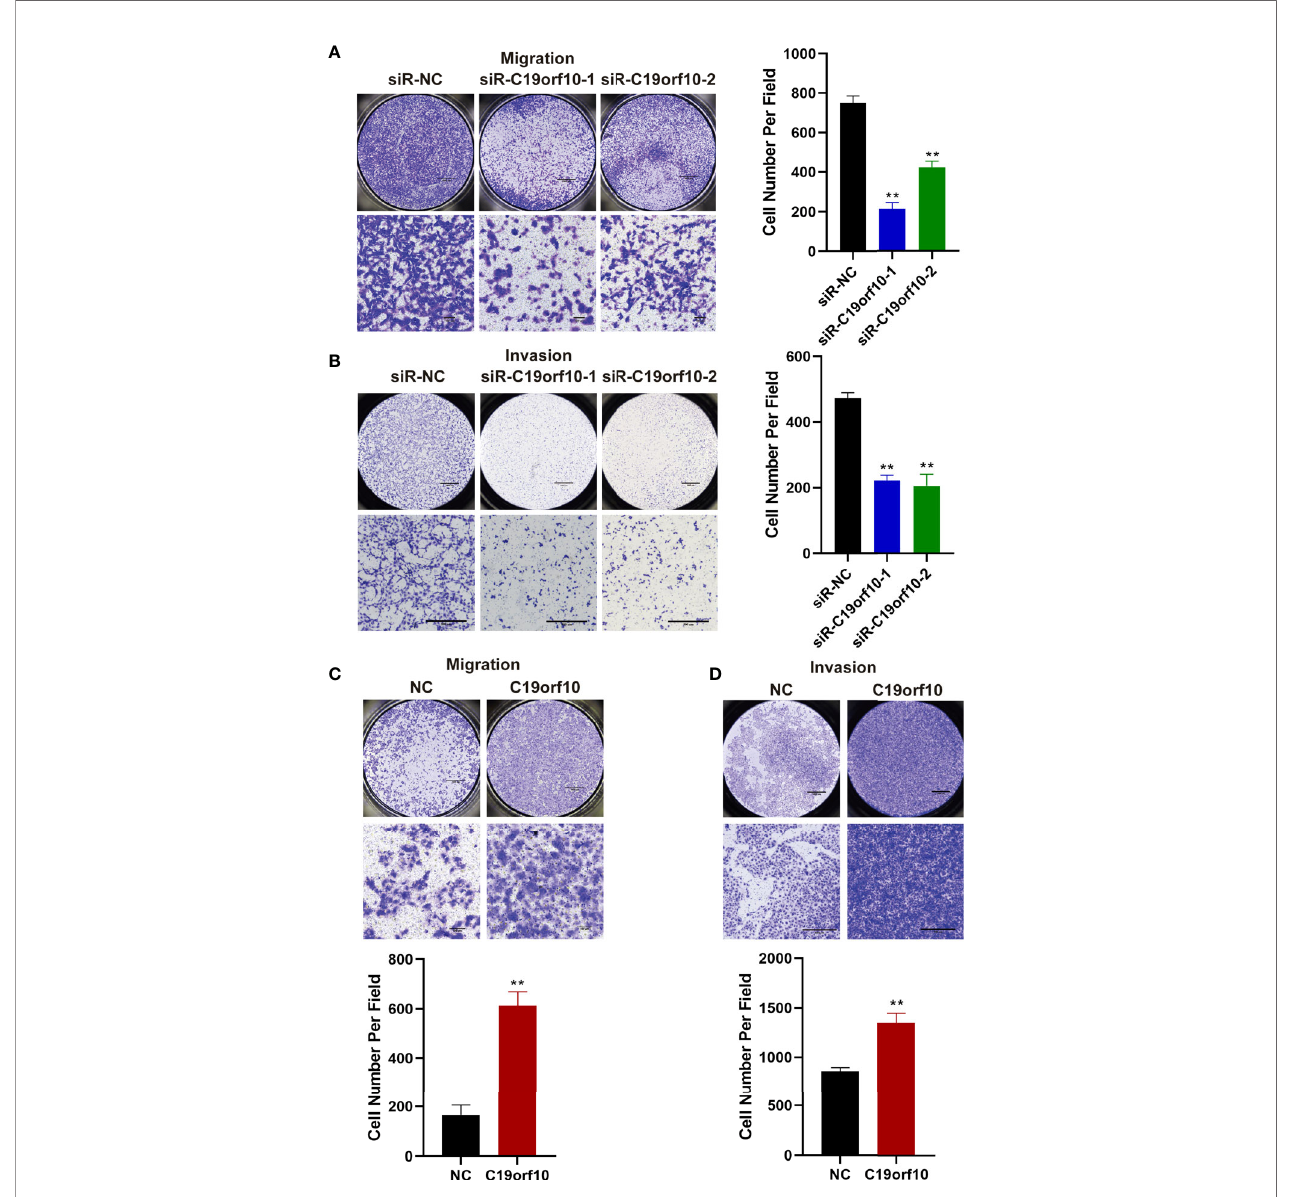
FIGURE 5 | C19orf10 promotes the migration and invasion of KIRC cells. (A, B) Silencing C19orf10 inhibited the migration and invasion ability of ACHN cell in transwell migration and invasion assay. (C, D) C19orf10 promoted the migration and invasion of 769-P cell. Scale bar, 1000 m m for overall images, 100 m m for partial migration pictures, 500 m m for partial invasion pictures. Mean ± SD is shown, n = 5. ** P < 0.01 by Student ’ s